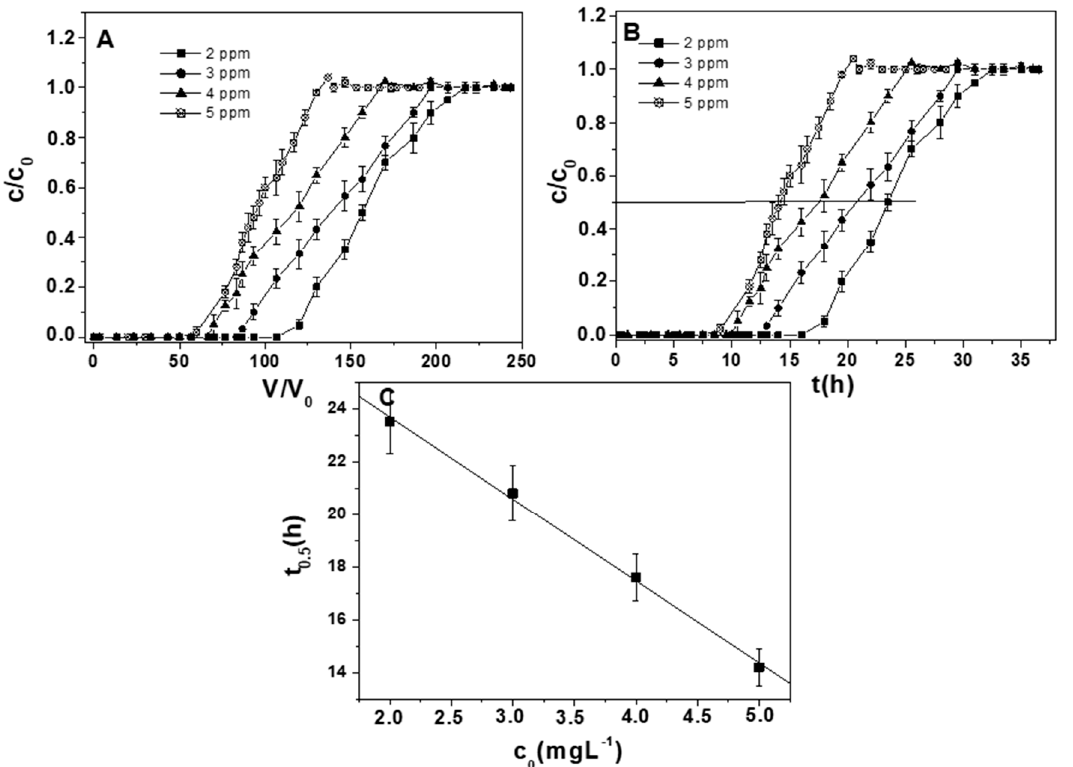
Figure 6. ( A ) Breakthrough curves in distilled water for lead ions in ternary solutions. Measurements carried out with 2, 3, 4, and 5 mg Pb +2 L − 1 (0.2 Lh − 1 flow rate, 10g RWPG, 0.5–1 mm bead size